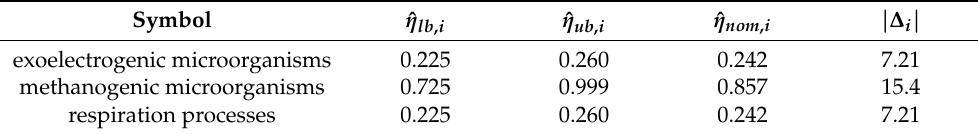
Table 5. Values of effectiveness factor for a microbial electrolysis cell biofilm. Symbol ˆ η lb , i exoelectrogenic